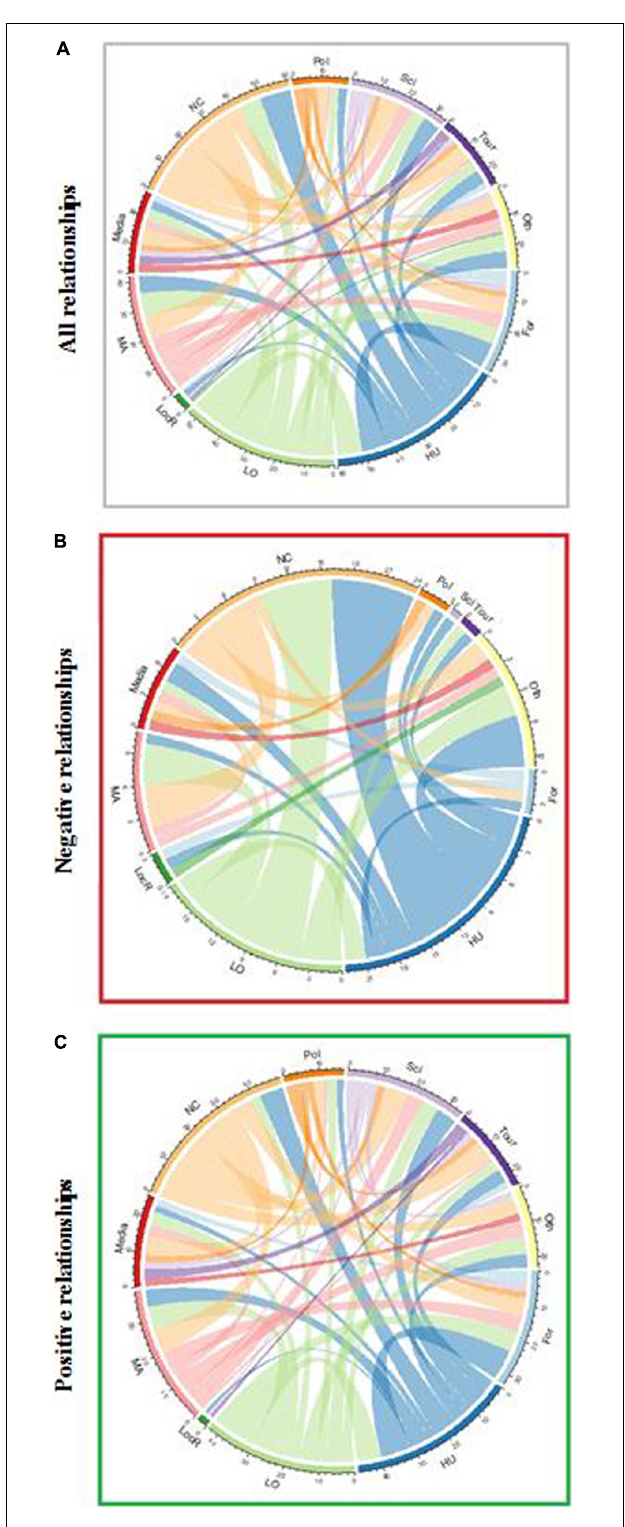
FIGURE 4 | Chord diagrams of relationships between the 10 Stakeholder Categories at European scale. (A) Sum of all relationships (B) Negative relationships (C) Positive relationships. Broader interconnecting stripes indicate more direct relationships between two stakeholder